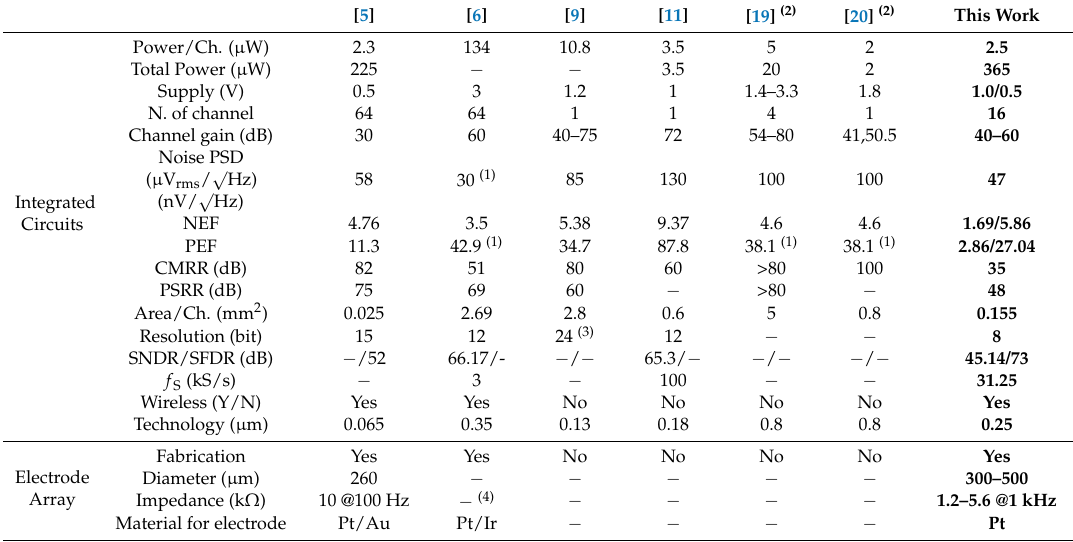
Table 2. Performance summary and comparison with recent ECoG and EEG works.